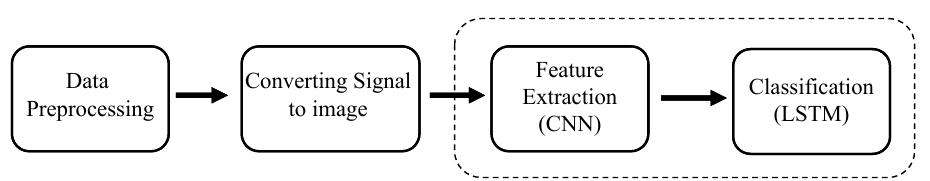
Figure 2. The framework of